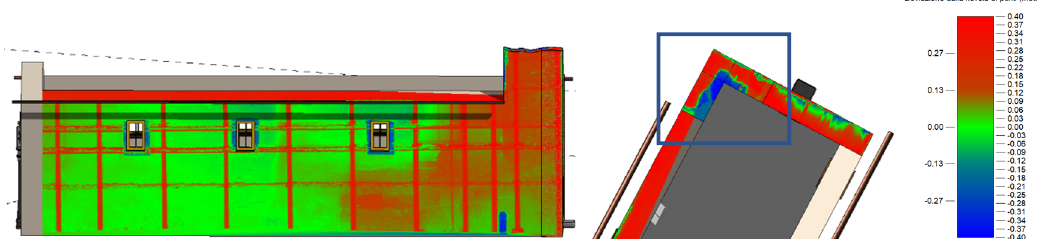
Figure 7. The deviation between the point cloud and the model. The highest deviation is noticeable on the damaged wall and bell tower (blue rectangle), in particular on the top of the side wall is due to the collapsed parts (ashlars and masonry) purposely not modelled.